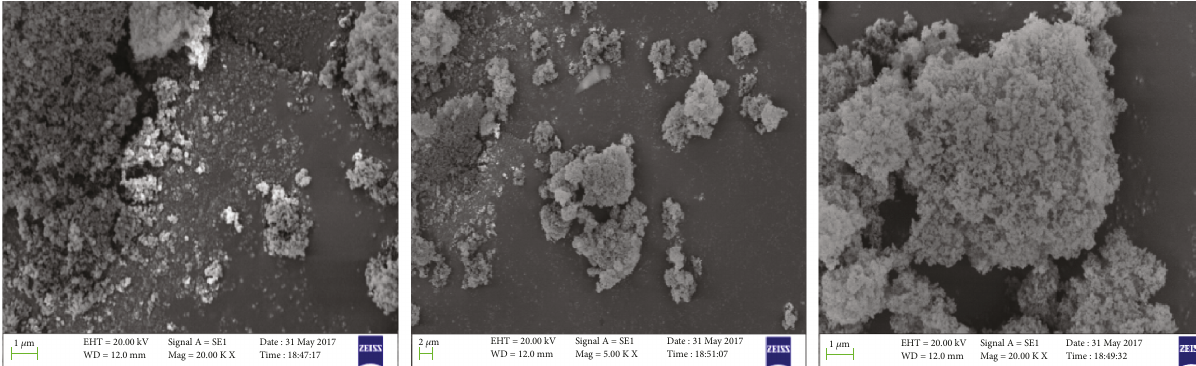
Figure 6: SEM pattern of SiO